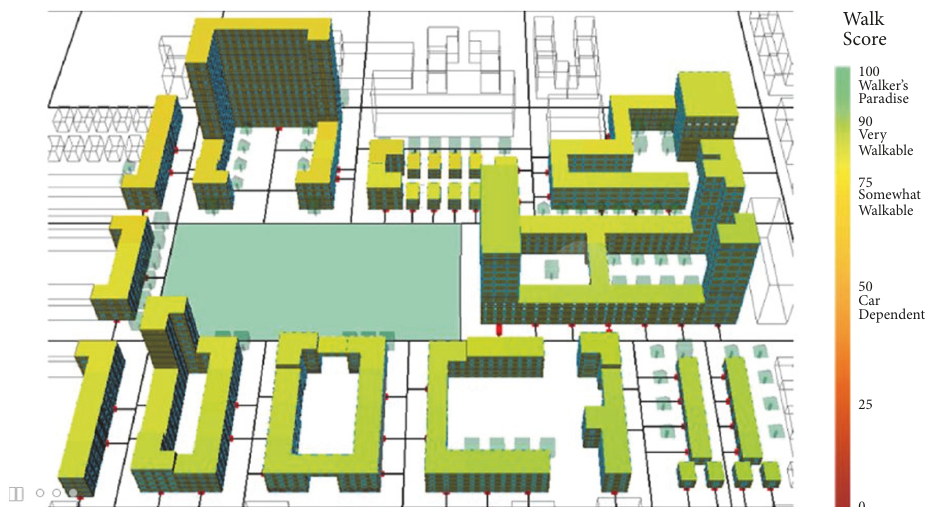
Figure 3: UMI output sample (Source: